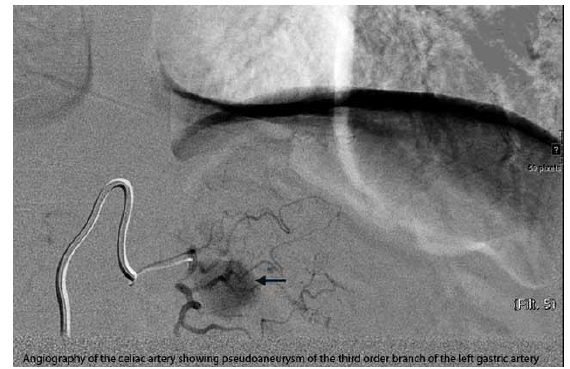
Figure 2. Angiography of the celiac artery showing a pseudoaneurysm of the third order branch of the left gastric